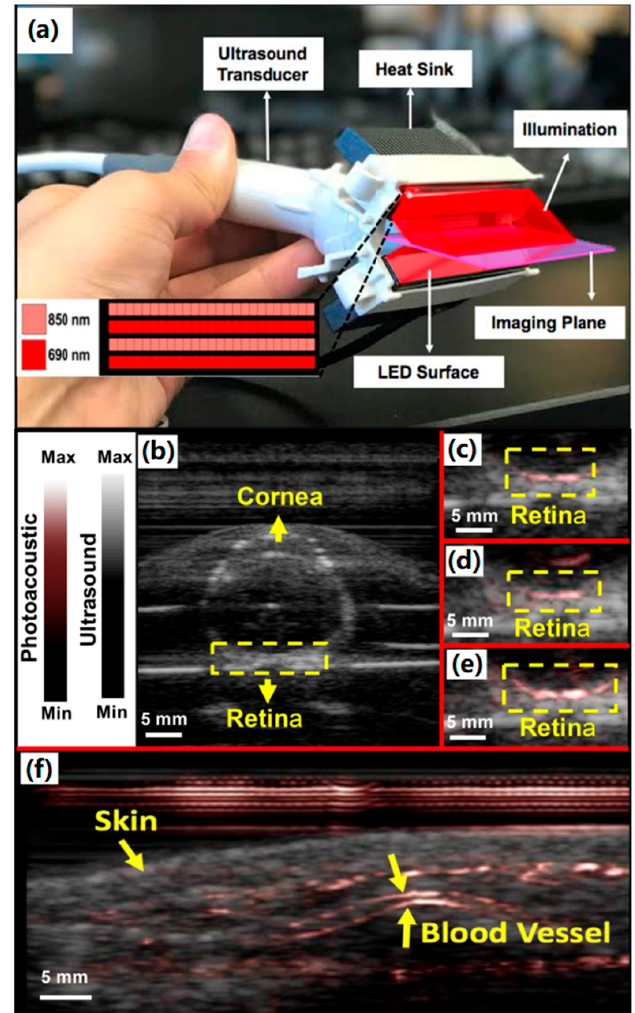
Figure 9. ( a ) PLED-PAI probe with imaging plane and illumination source are shown